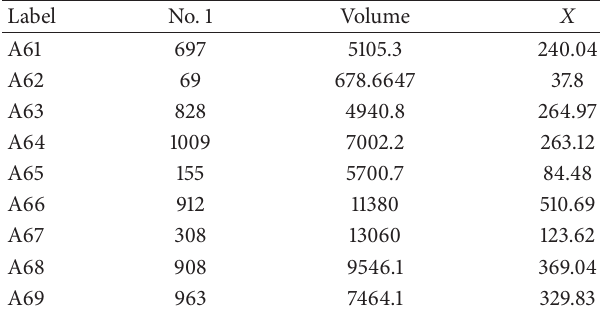
Table 5: Standard data in data set A.